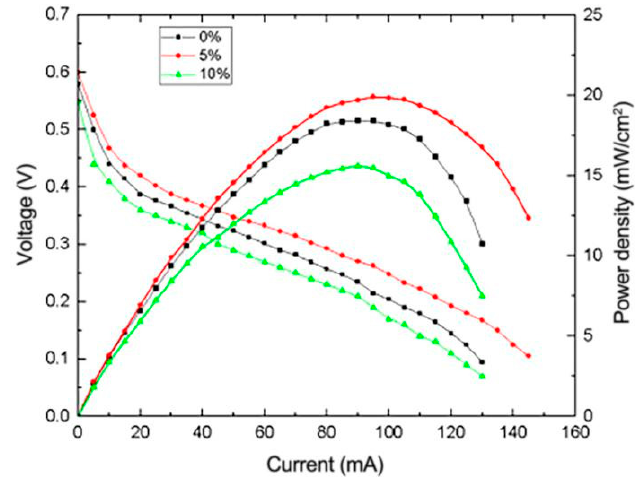
Figure 13. Effect of different PTFE content amounts on the performance of μ DMFC.